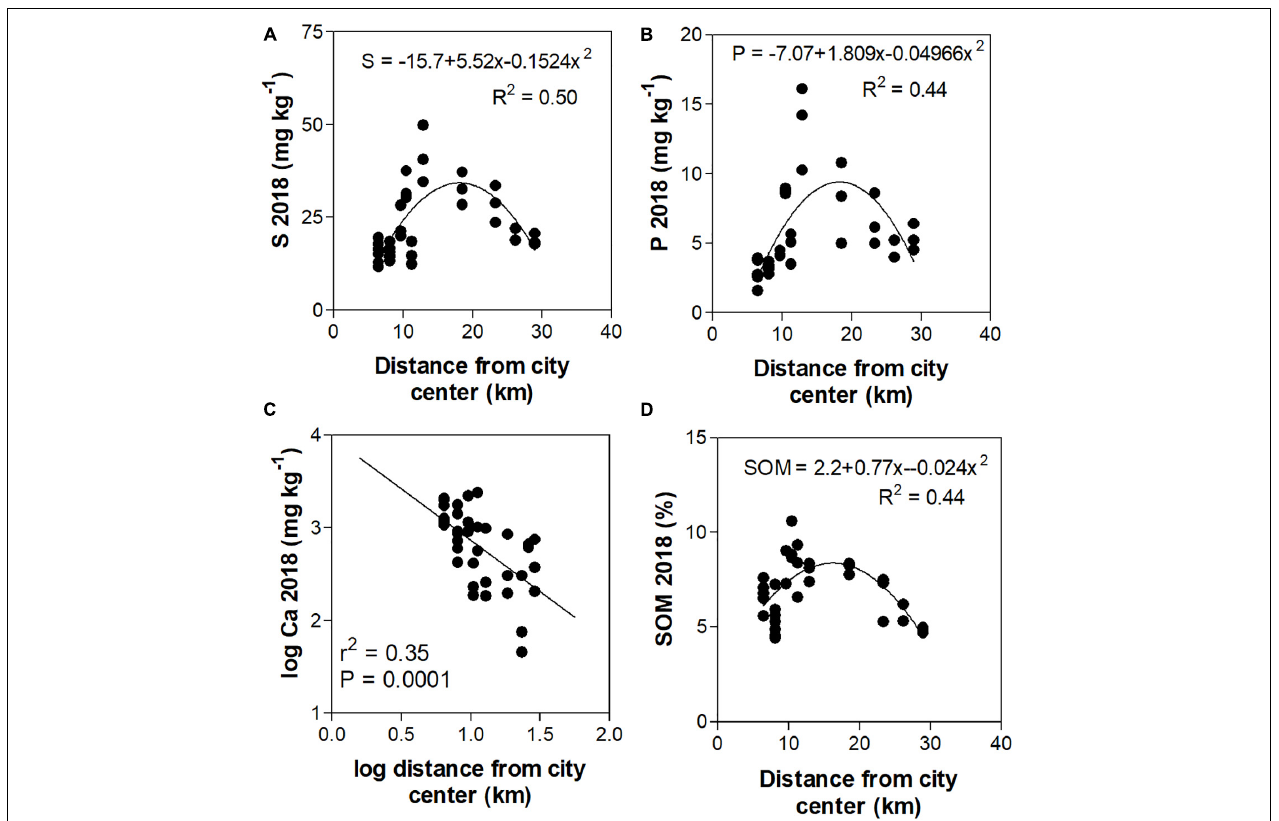
FIGURE 8 | Concentration of some four surface soil characteristics along the urban–rural gradient, expressed as the distance from the city center. Points represent plot-level data ( n = 36). Only 2018 data are shown. Equations for S (A) , P (B) , and SOM (D) represent polynomial best fit, and Ca (C) is represented by linear regression of log-transformed Ca concentration and distance from the city